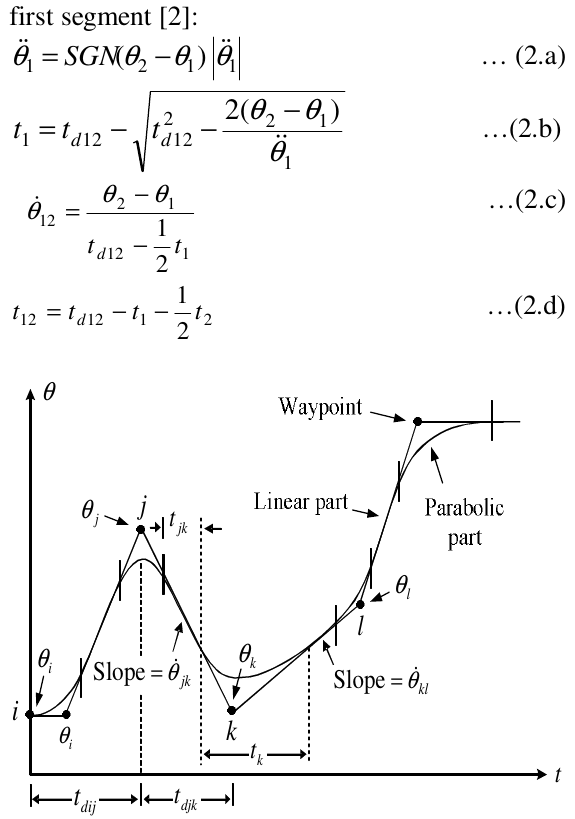
Fig. 1. Multisegment linear path with blends